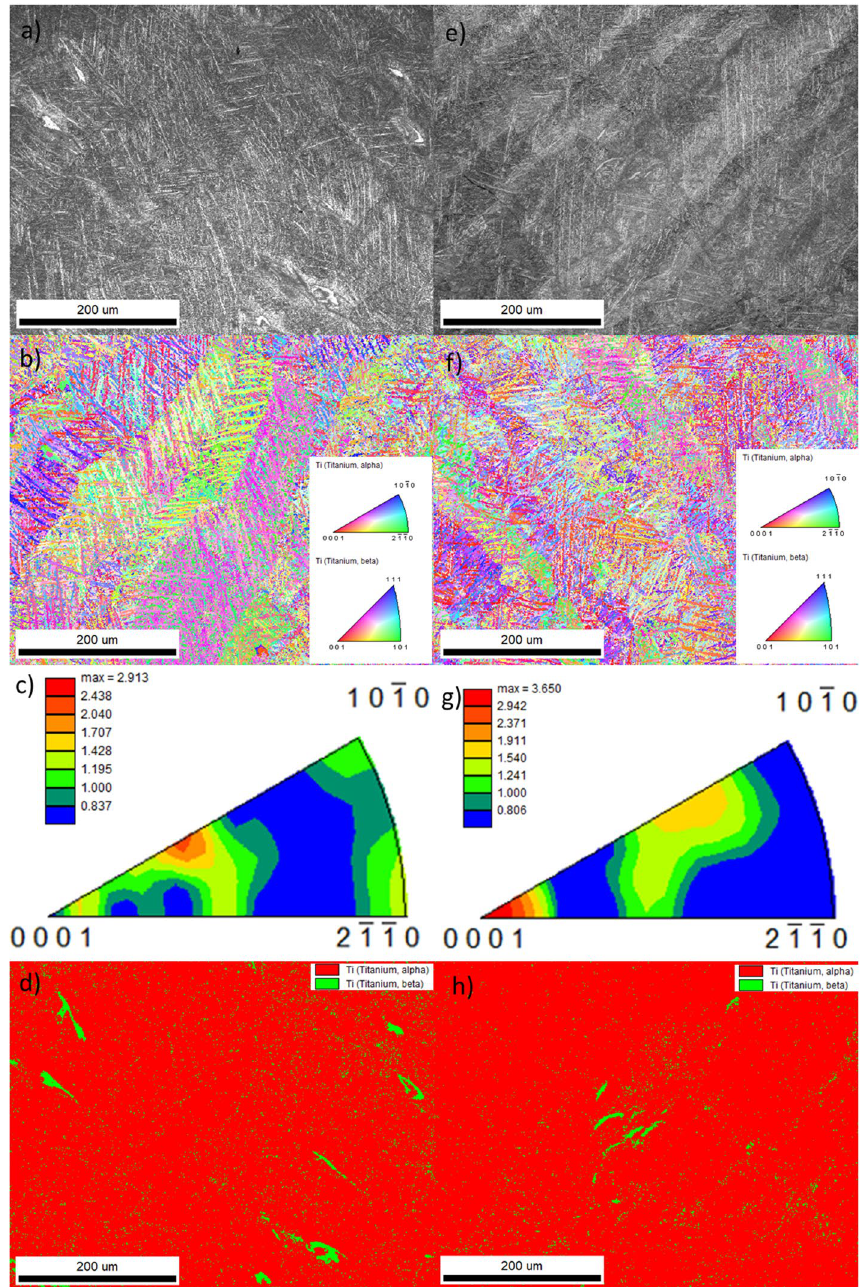
Figure 9. SEM micrographs of Ti6Al4V printed from virgin ( a ) and reused powder ( e ); EBSD orientation maps for the virgin ( b ) and reused (f) powder, IPF in [001] direction for the virgin ( c ) and reused ( g ) powders, and phase distributions for the virgin ( d ) and reused ( h )